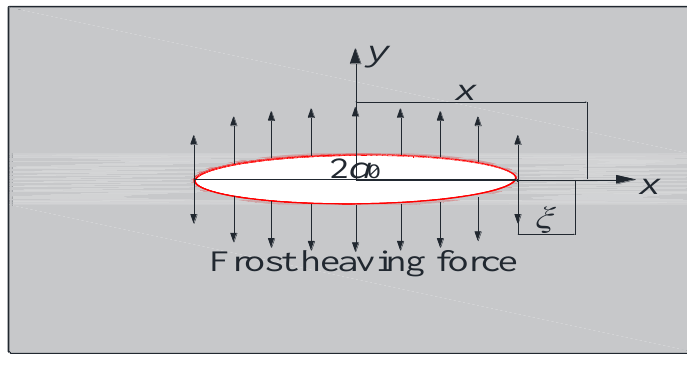
Figure 11. Type I fracture stress state.